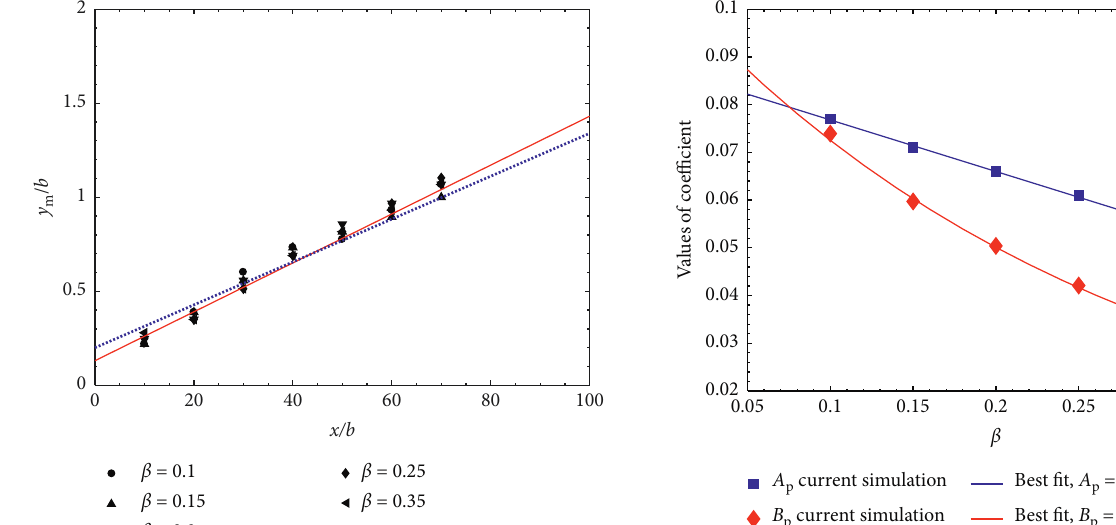
p and B p with respect to various velocity